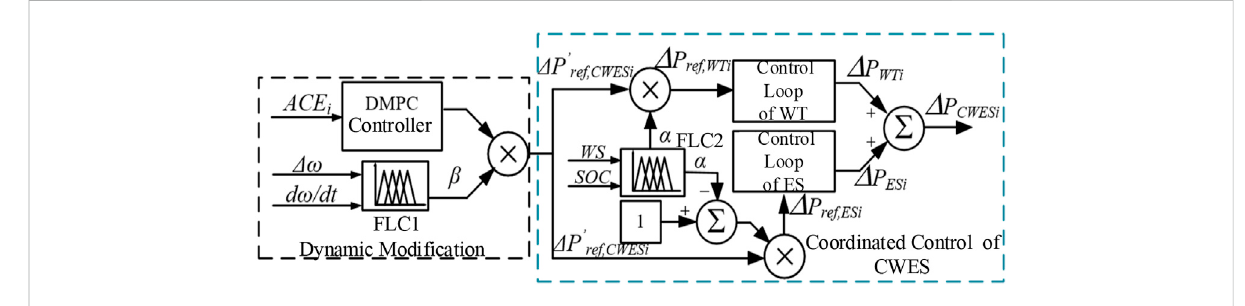
FIGURE 4 Coordinated control and dynamic modi fi cation diagram of CWES.